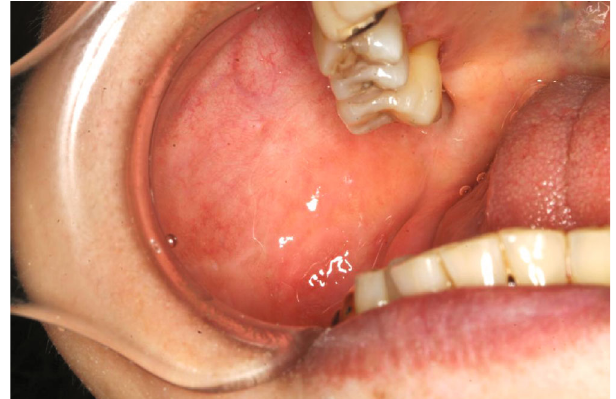
Figure 2: Intraoral photograph showing the absence of swelling or